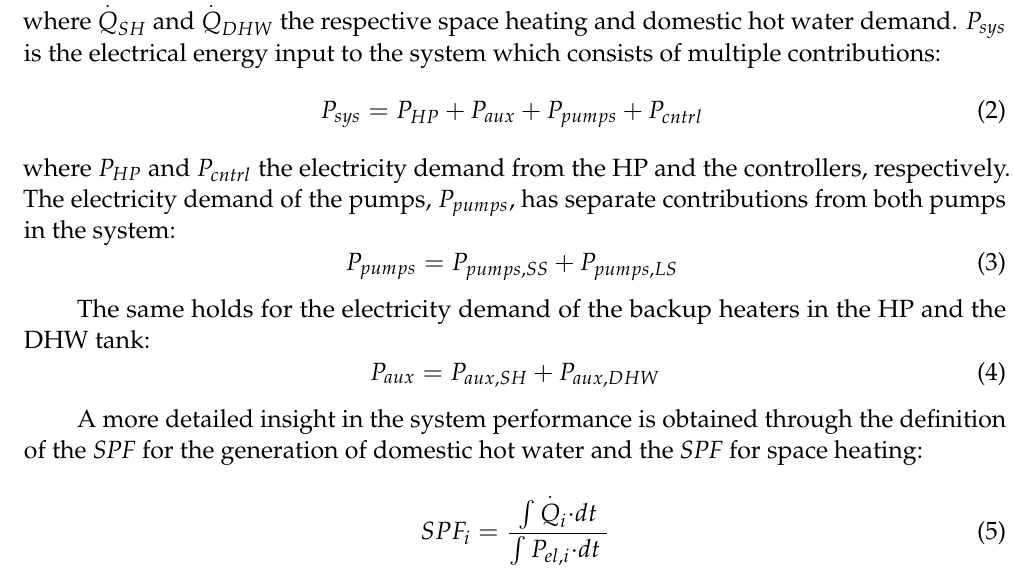
Figure 8. PVT-HP reference system configuration implemented in the Template Solar System of IEA SHC Task 32.